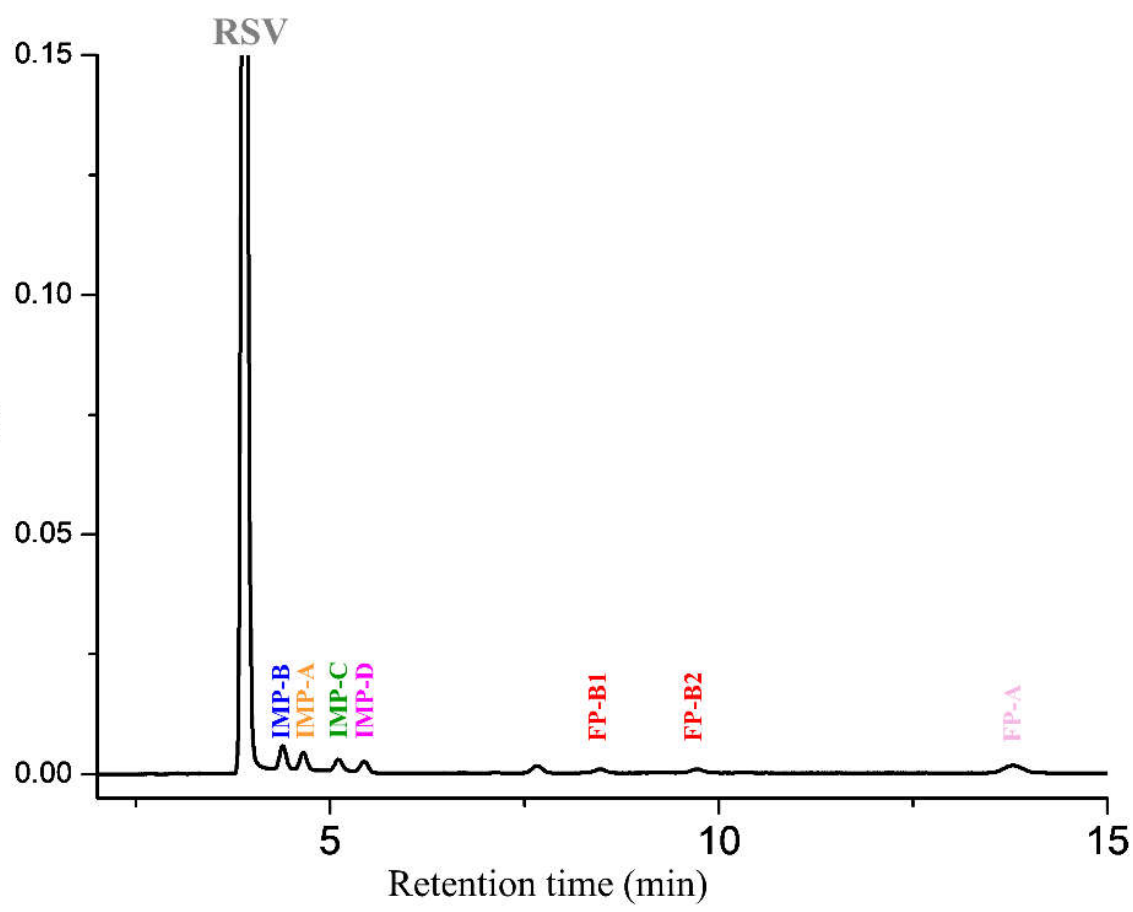
Figure 3. Optimized UHPLC chromatogram of RSV spiked with impurities. Chromatographic conditions: column, Acquity BEH C18 (100 mm × 2.1 mm, 1.7 μm); mobile phase, MeOH-TFA 0.025%